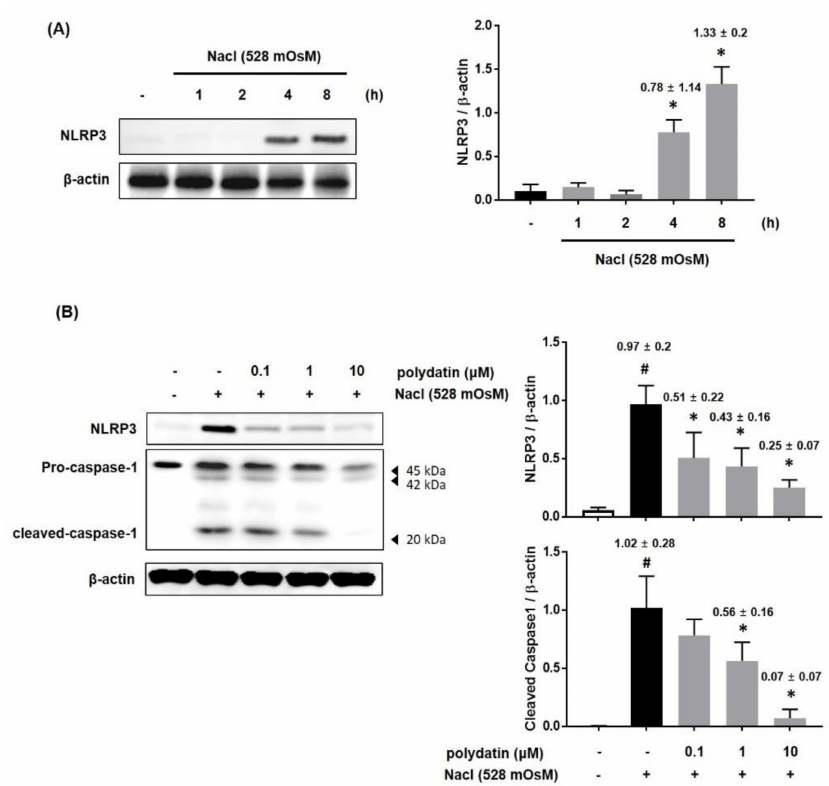
Figure 7. E ff ects of polydatin on NLRP3 expression in hyperosmolar stress-induced HCCs. ( A ) HCCs were treated to hyperosmotic media (528 mOsM) for each time or 8 h. ( B ) The protein expression of NLRP3 and caspas-1 was analyzed by western blotting analysis. The relative intensities are expressed as the ratio of NLRP3 and cleaved caspase-1 to β -actin. Data are the mean ± SEM of three independent experiments for all groups. # p < 0.05, significantly di ff erent from untreated group, * p < 0.05, significantly di ff erent from hyperosmotic-treated